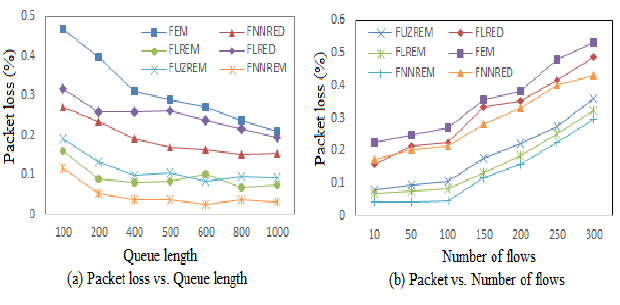
Figure 17.. Packet loss rate of AQM mechanisms